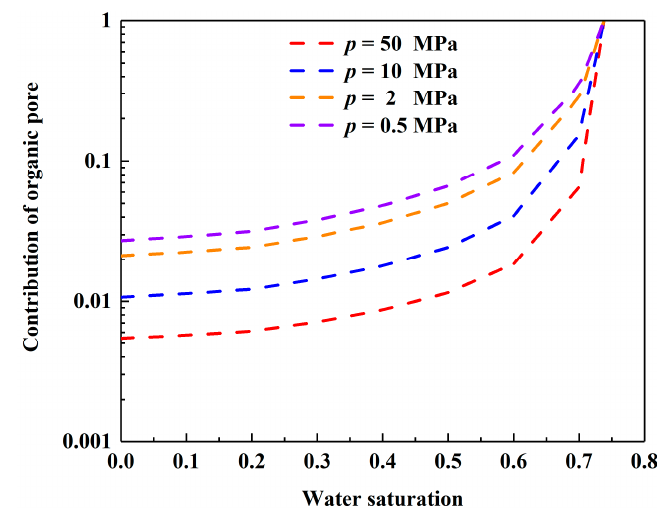
Figure 18. The contribution of ORM to total AGP varies water saturation.